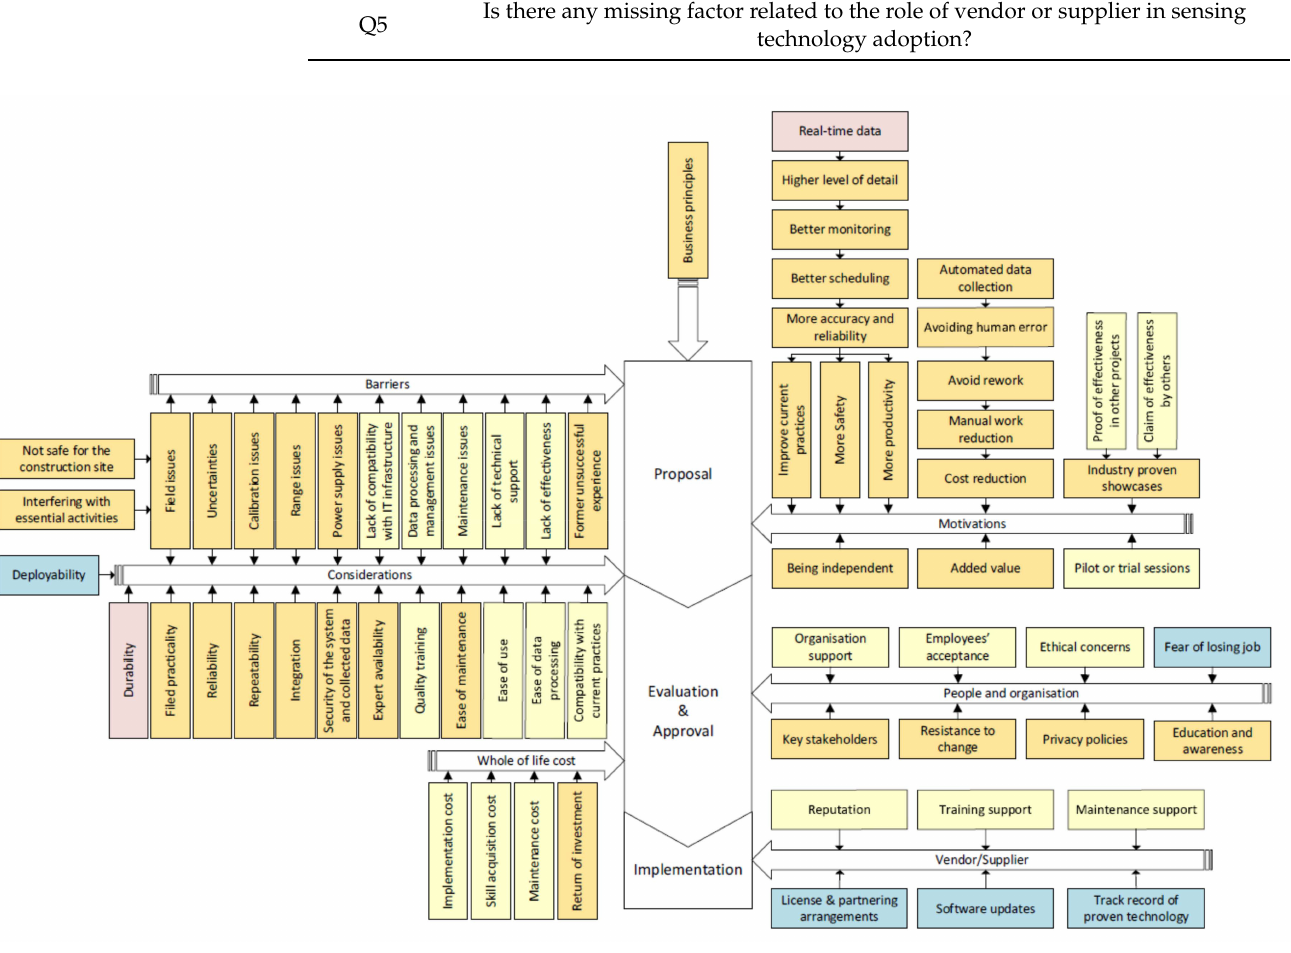
Figure 14. The governance